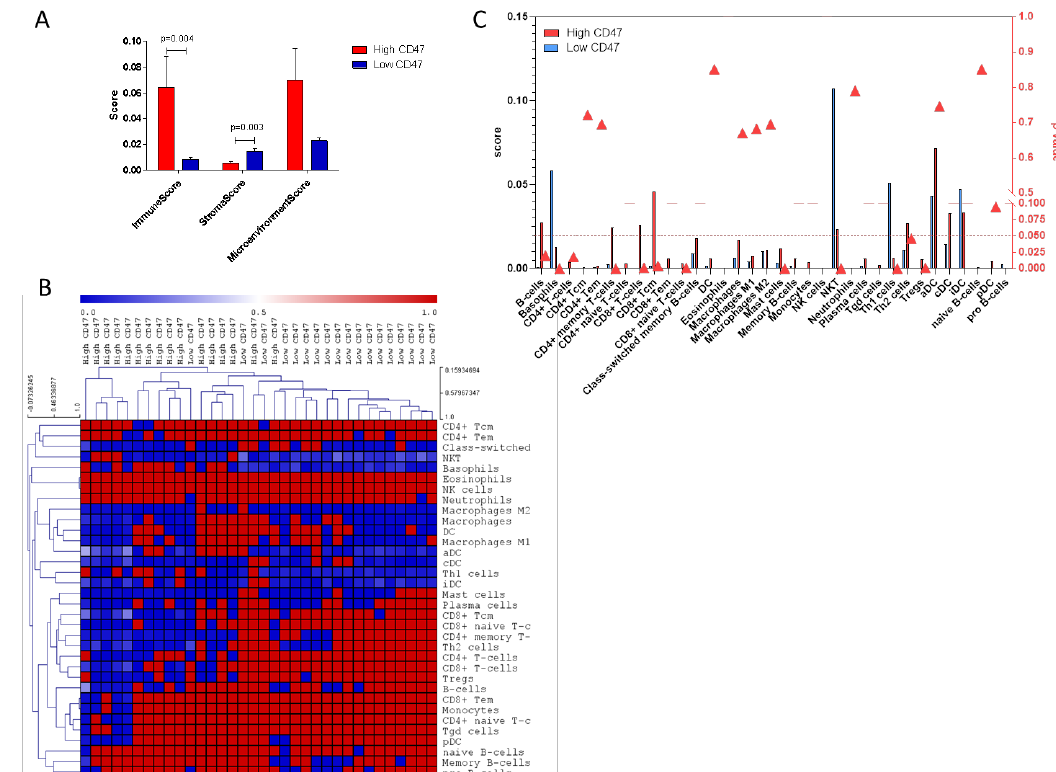
Figure 4. ( A ) Deconvolution analysis showing differences in immune score, stroma score, and microenvironment score between patients with high CD47 expression levels as compared to patients with low CD47 expression levels; ( B ) Heatmap showing the results of the deconvolution analysis for the infiltrating immune populations in patients with high CD47 expression levels as compared to patients with low CD47 expression levels; ( C ) Histogram plot showing the results of the deconvolution analysis for the infiltrating immune populations in patients with high CD47 expression levels as compared to patients with low CD47 expression levels. Red triangles indicate the p-value for differences between the two patients’ populations. The red dotted line indicates the threshold of significance for the p-value ( p = 0.05).